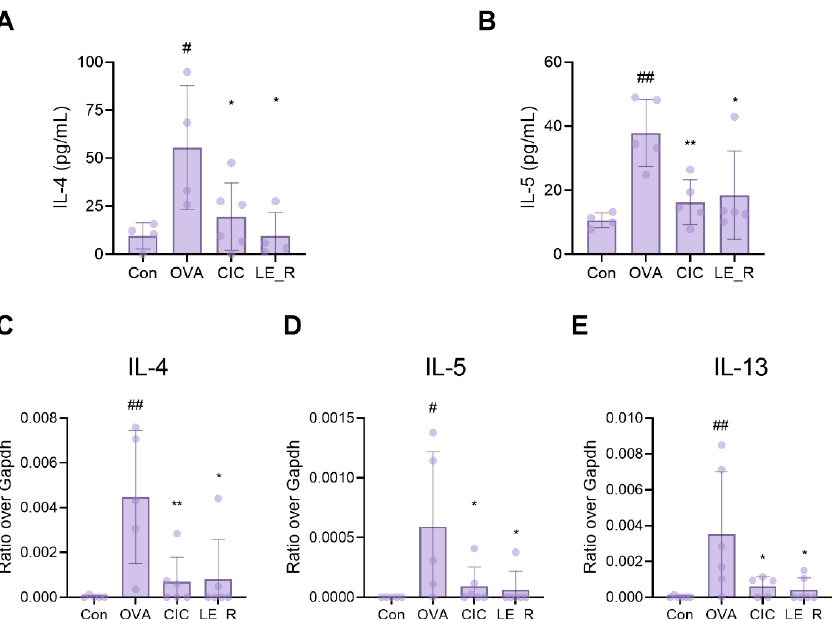
Figure 4. Effect of L. erythrorhizon reflux ethanol extract on cytokine levels in the serum and nasal lavage fluid of mice with OVA-induced allergic rhinitis. The concentrations of ( A ) IL-4 and ( B ) IL-5 in the serum of mice were measured using ELISA kits. Levels of ( C ) IL-4, ( D ) IL-5, and ( E ) IL-13 mRNA in NALF were measured by quantitative real-time RT-PCR. Data are expressed as the mean ± SD ( n = 4~6 per group). # p < 0.05, ## p < 0.01 versus the Control group. * p < 0.05, ** p < 0.01 versus the ovalabumin group. Con, control; OVA, ovalbumin; CIC, ciclesonide; LE_R, reflux ethanol extract of L. erythrorhizon .